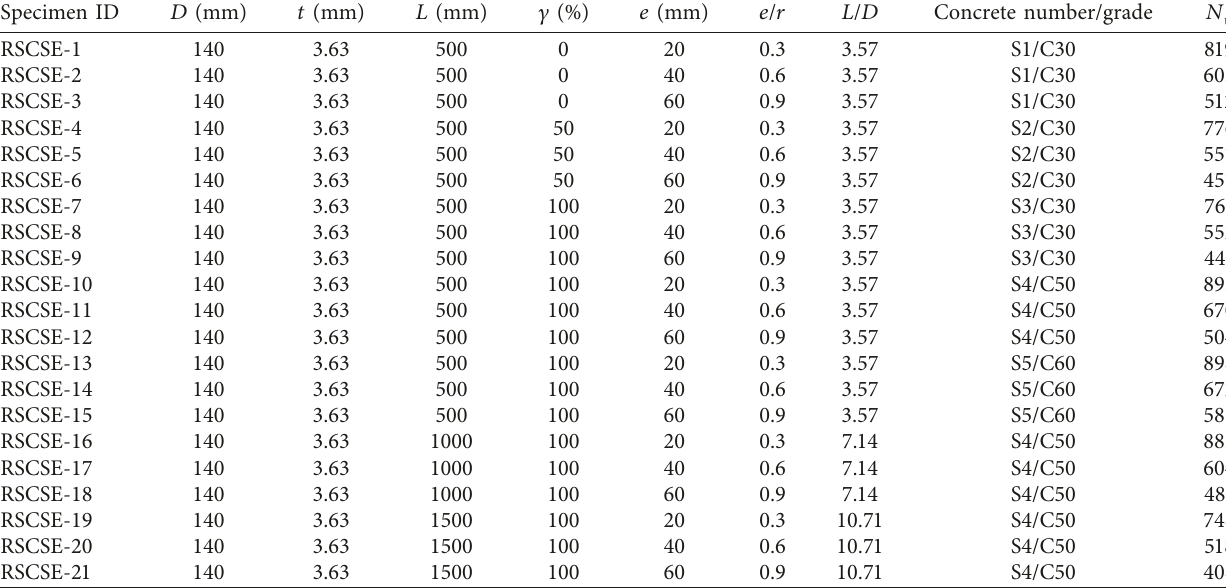
Table 1: Parameters of RSCFCST columns.